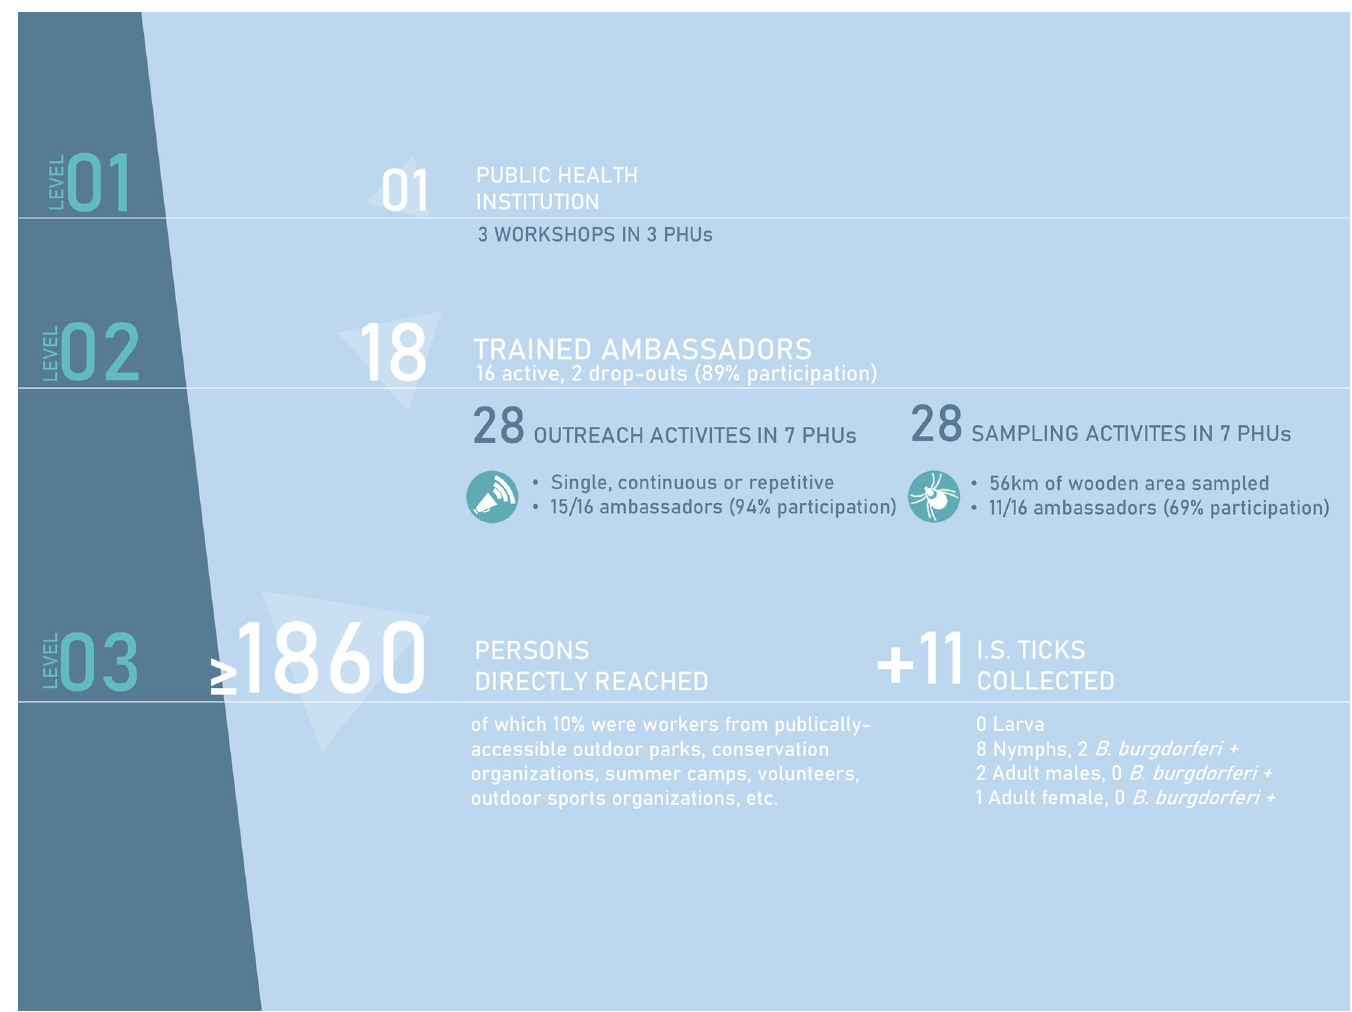
Fig 5. Visual overview of results obtained using a training-of-trainer inspired approach to train outreach and sampling ambassadors. Results grow increasingly from one level to the next (top to bottom), from a single PH institution leading three workshops, to 18 trained ambassadors leading 28 outreach activities and 28 tick samplings, reaching over 1 860 persons directly in seven PHUs and collecting 11 I . scapularis ticks.